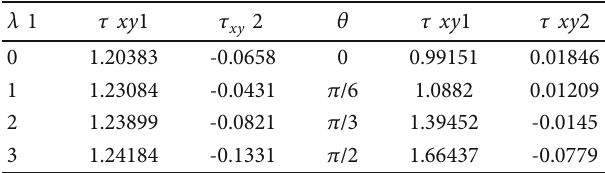
Table 4: Variation of shear stress with Je ff ery fl uid parameter ( λ and angle of inclination ( θ ) at the lower plate ð τ xy 1 Þ and at the upper plate ð τ xy 2 Þ .